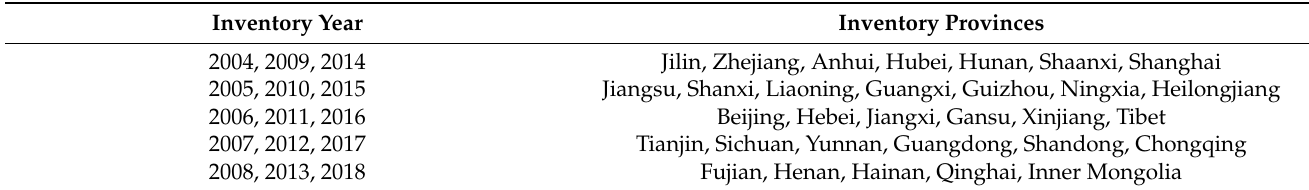
Table 3. Forest resources Inventory of China from 2004 to 2018.